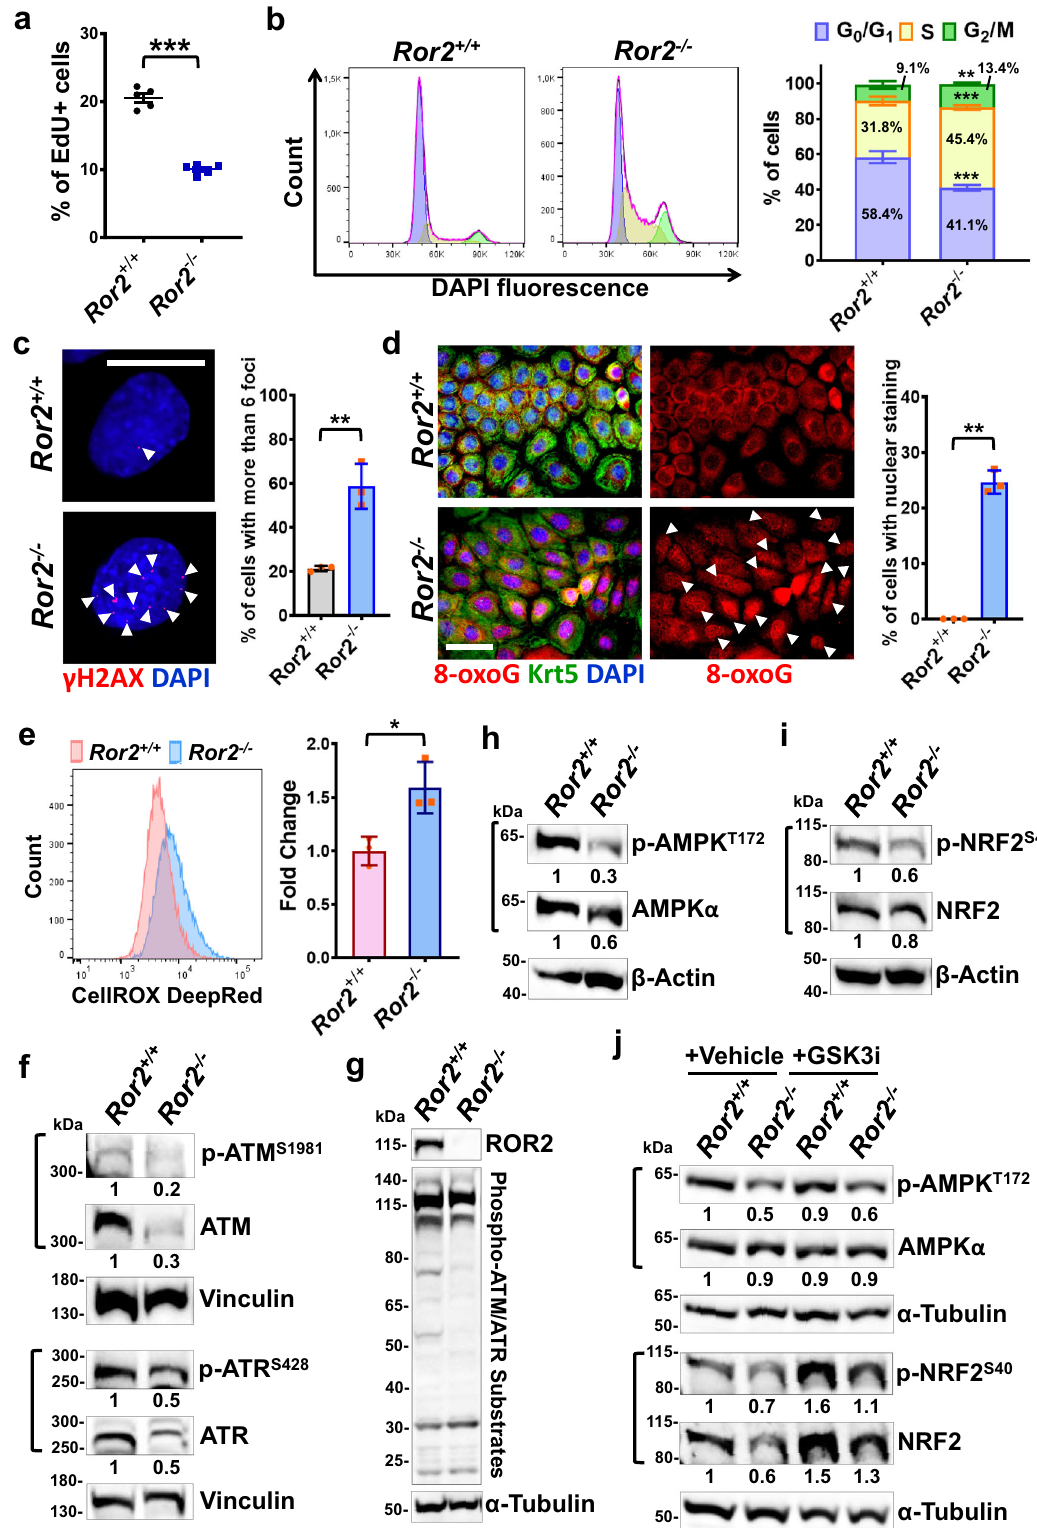
(Fig. 2e, f) or in the late telogen β -cat cKO HFSCs (Fig. 6b). In